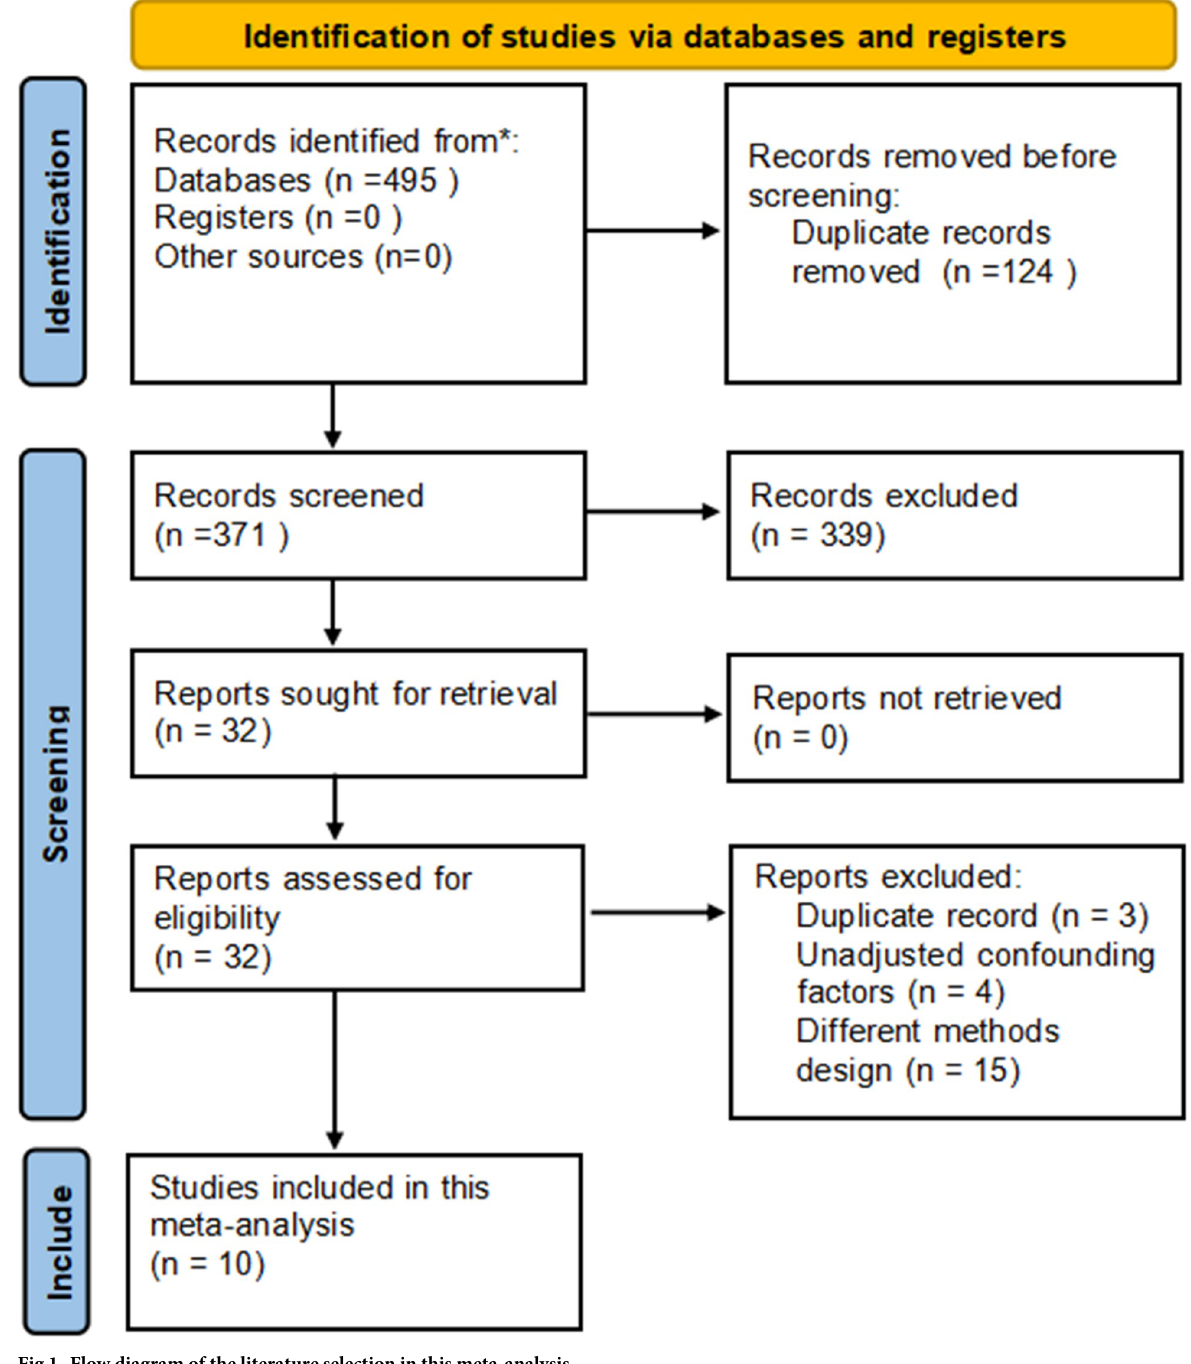
Fig 1. Flow diagram of the literature selection in this